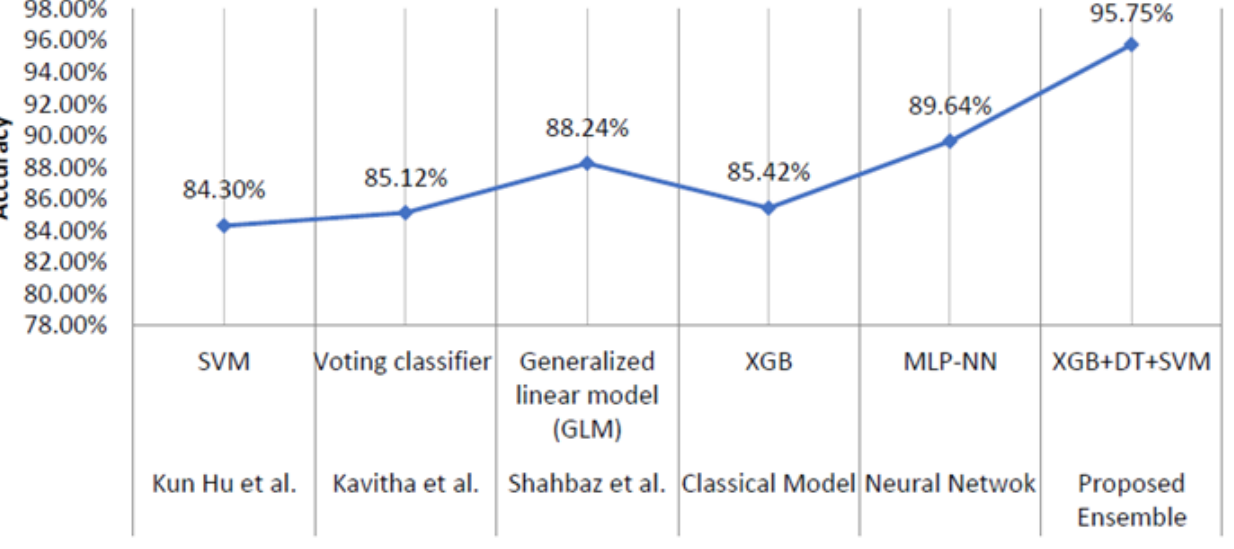
Figure 10. A graphical representation of comparison between best performing XGB proposed XGB+DT+SVM and MLP-NN with previous studies